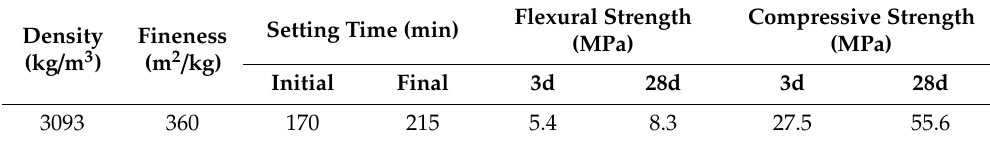
Table 2. Physical and mechanical properties of ordinary silicate cement.